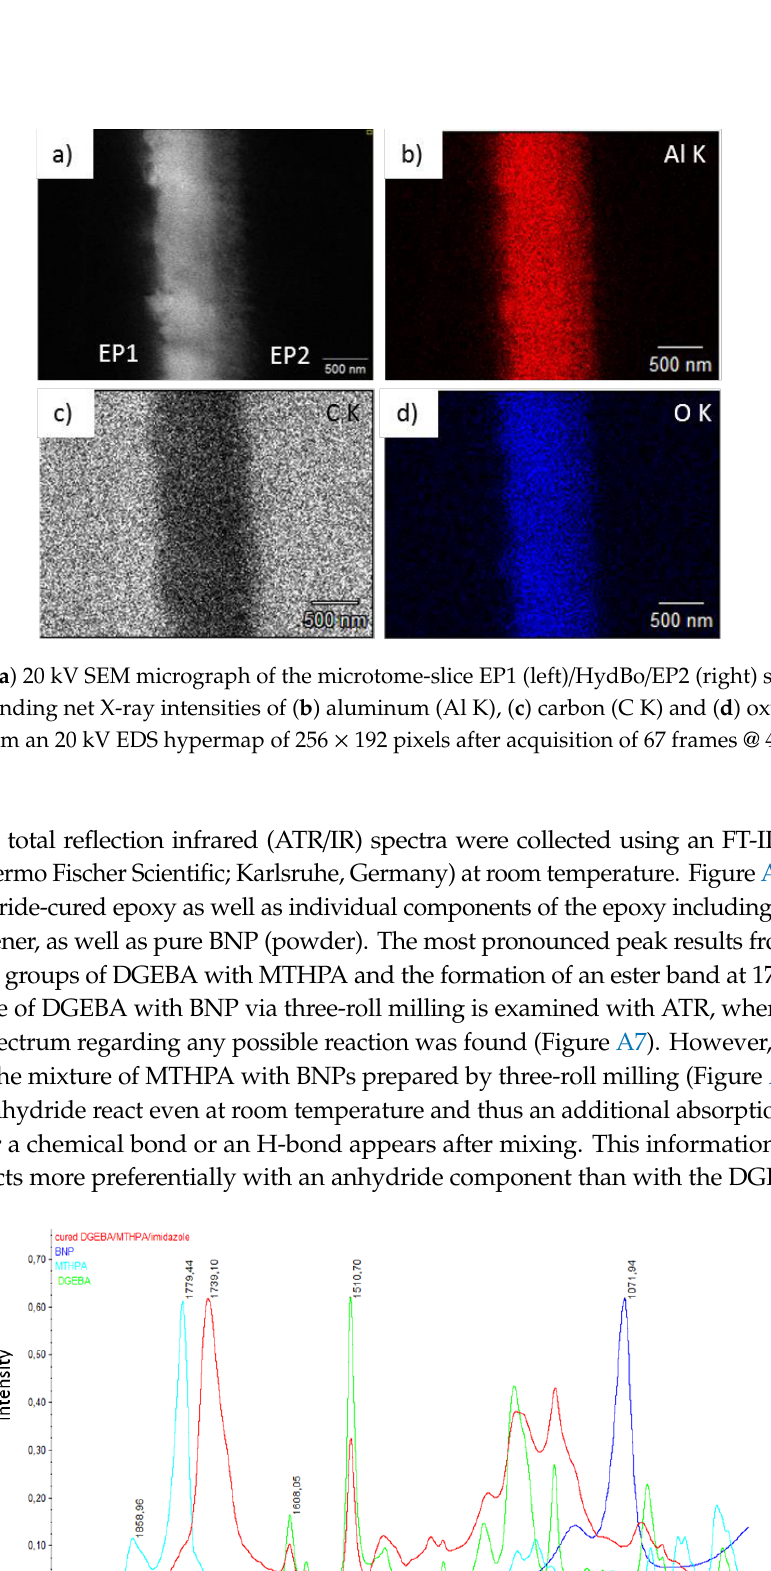
Figure C1. Force distance curves (FDC) stiffness map (inset image) and average force-distance curves of the cross-sectional surface of EP1/HydBo/EP2.